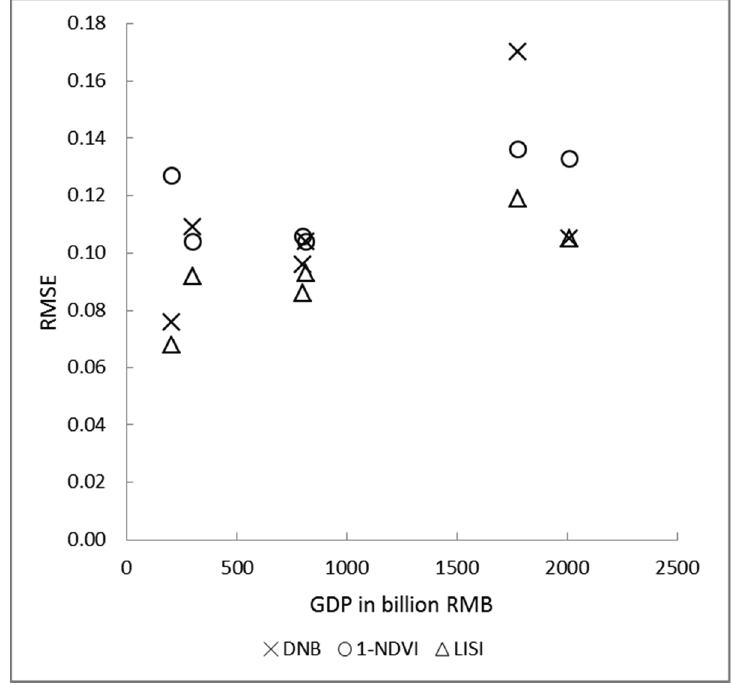
Figure 9. The relationship between RMSE and economic conditions, showing the effects of different economic conditions on ISA estimation performance through the comparison of different